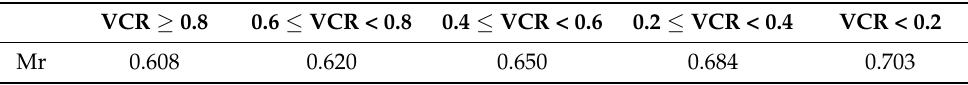
Table 5. Multiple linear correlation coefficient results of annual NDVI with precipitation and net radiation under different vegetation coverage